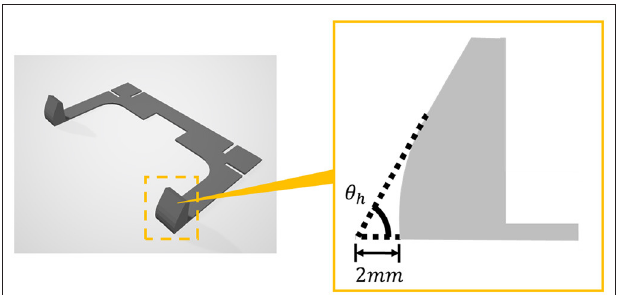
FIGURE 6 | The structure of Frame A and enlarged view of hinge part. Hinge part is rounded as shown in the right figure so as not to impede the drive of the structure by applying